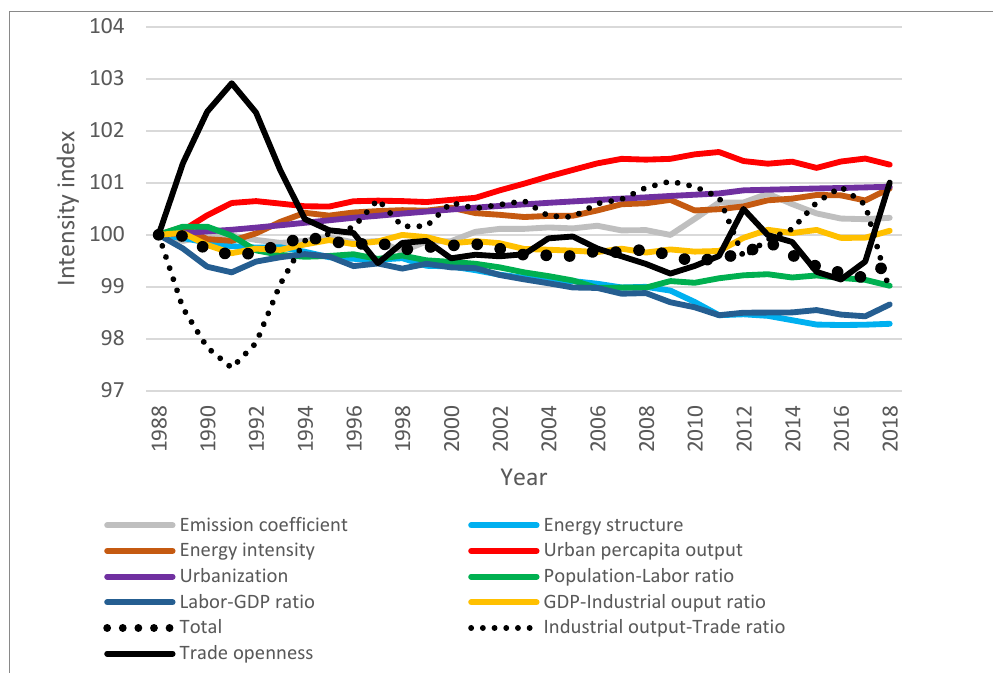
Fig. 6: NO emission inten sity and its x Fig. 6: NO x emission intensity and its components